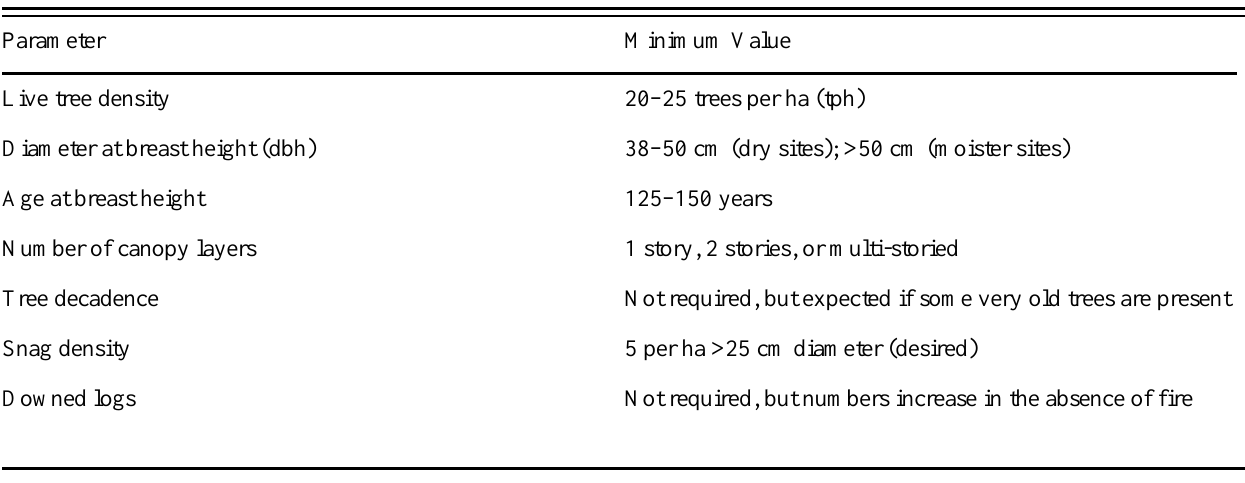
Table 2. Minimum stand structural requirements for old-growth ponderosa